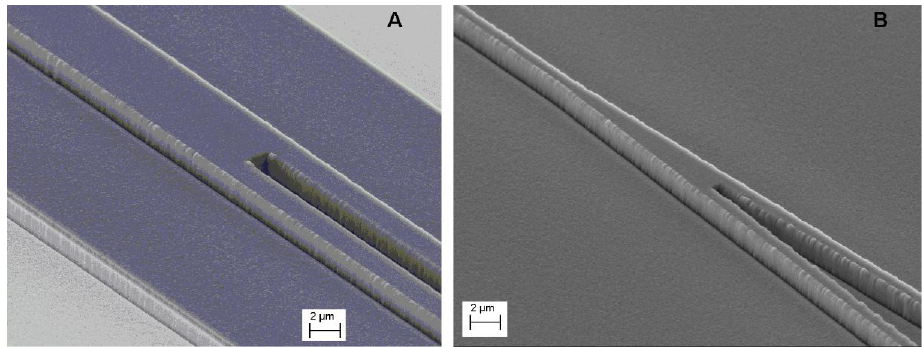
Fig. 8. Photomicrography of waveguide cross-section of etched InP/InGaAs heterostructure. This mode allowed etching without using additional heating of the substrate. Photo- micrography of Y- and MMI dividers on InP semiconductor substrate is presented in Fig. 9